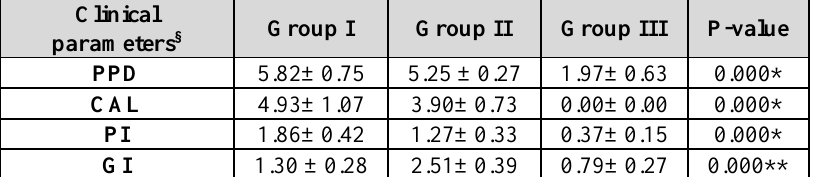
Table 1: Comparison of the three groups with respect to clinical periodontal parameters.